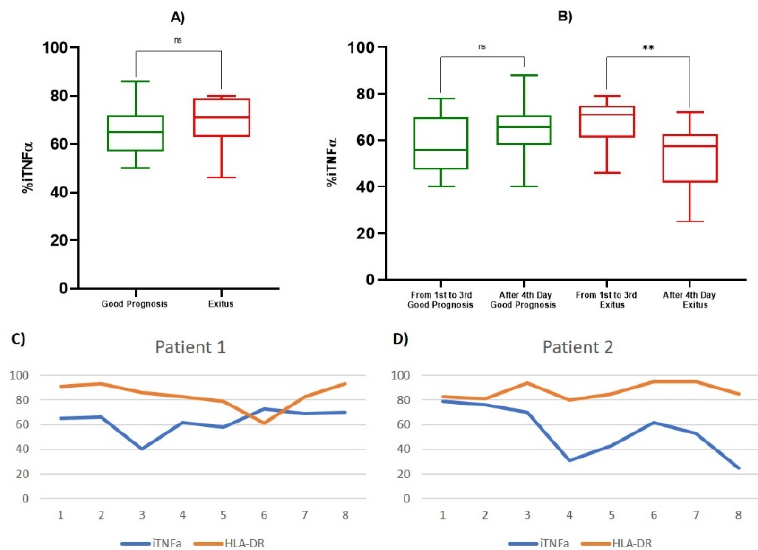
Figure 3. Box and whiskers for iTNF- α and levels of iTNF- α and HLA-DR. ( A ) Box and whiskers for percentage of iTNF- α positive monocytes at first determination in the Good Prognosis and Exitus groups; ( B ) box and whiskers for percentage of iTNF- α positive monocytes in good prognosis and exitus groups for determinations between the first and third day and from the fourth day onward; ( C ) example of iTNF- α and HLA-DR percentage trends in a patient with a good prognosis (total of eight determinations); ( D ) example of the iTNF- α and HLA-DR+ percentage trends in a patient with exitus (total of eight determinations). The significant p -values are marked with ** (from 0.001 to 0.01), not significant are marked with ns ( ≥ 0.05).